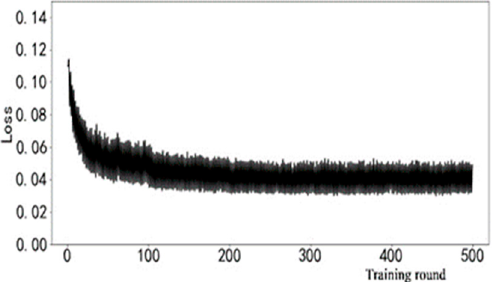
Figure 32. Loss curve of 50% expert-driven learning.